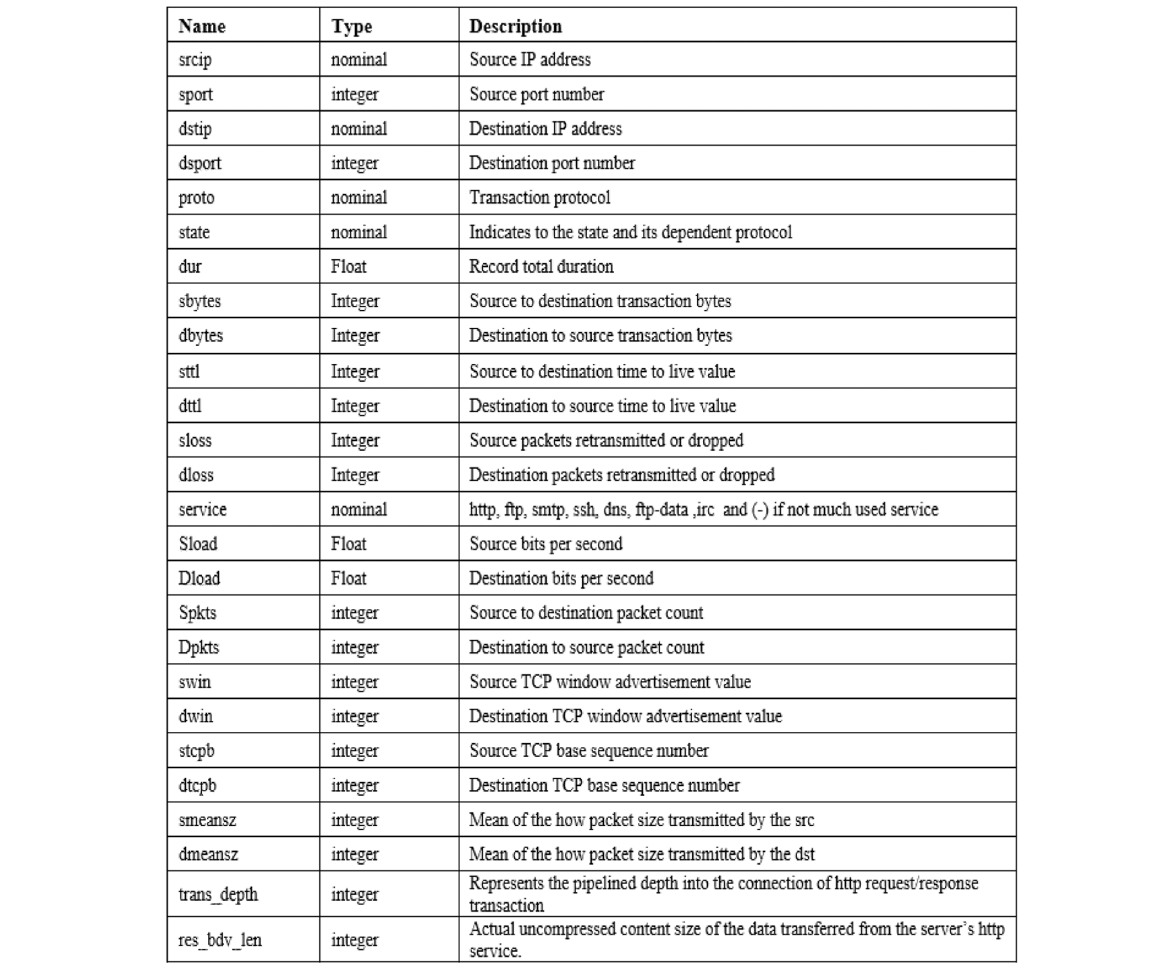
Table 8 Features of ADFA-LD dataset (Creech,